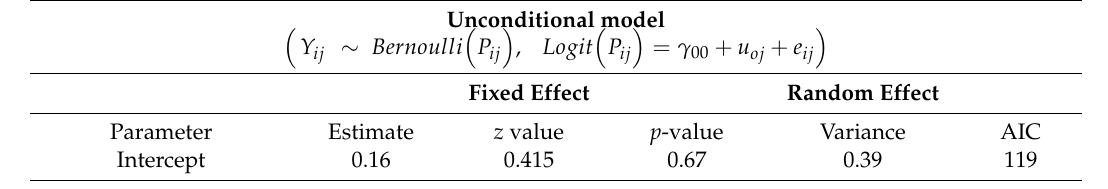
Table 2. Unconditional ( upper ) and hierarchical logistic regression ( lower ) models of the occurrence (cid:17) (cid:16) Y ij of Korean fir seedlings with plot-level explanatory variables (cid:16) (cid:17) Z j variables using the maximum likelihood method (Laplace